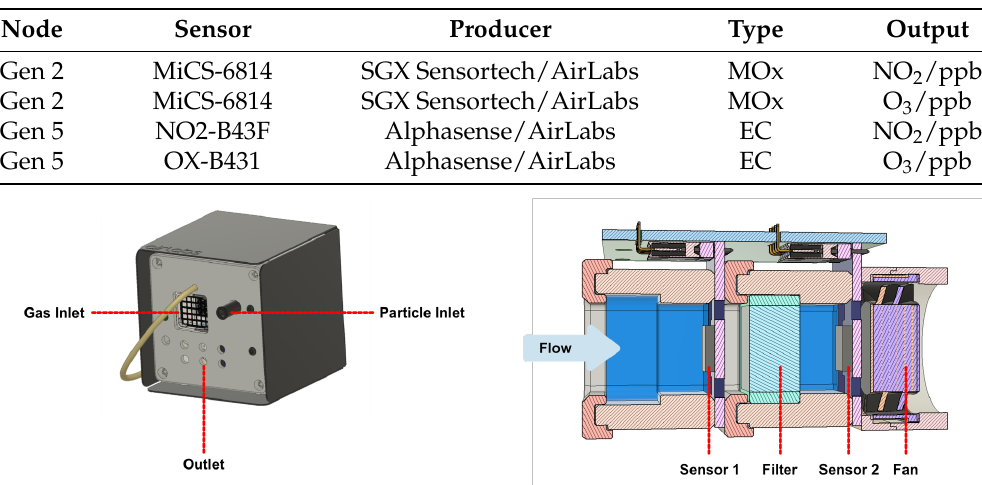
Table 1. Relevant sensors within the Gen 2 and Gen 5 nodes. The output column describes sensor output after processing and calibration.